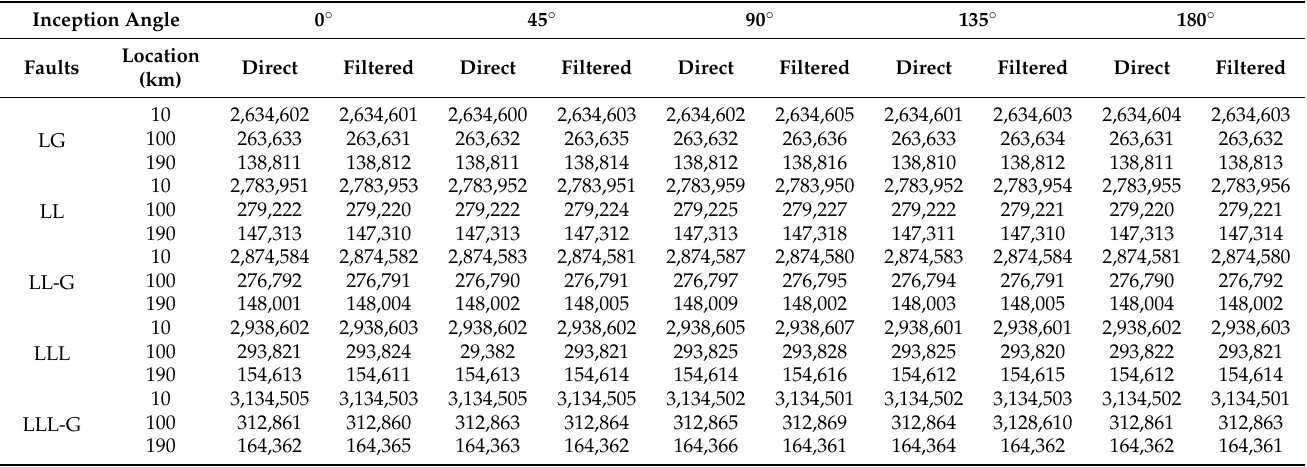
Table A6. Max singular values of FRFT-SVD results for direct and filtered current signals at various faults and inception angles with R = 100 Ω .